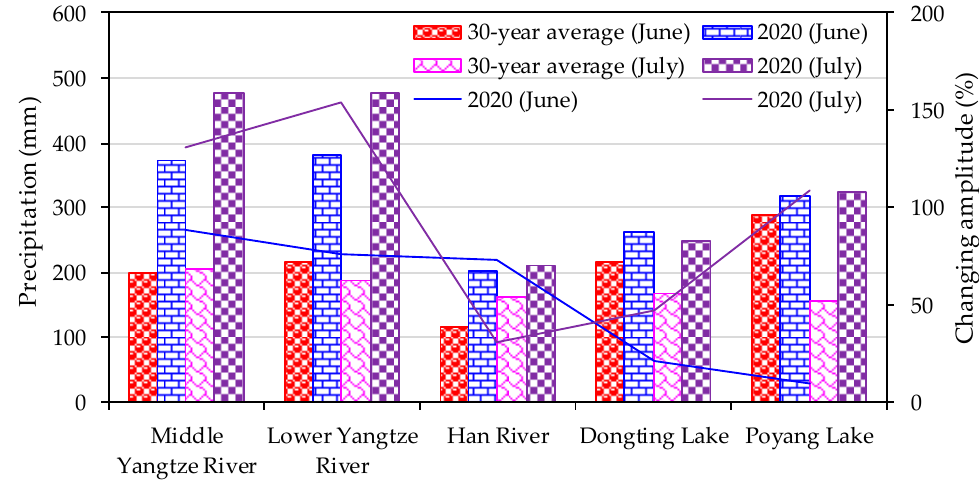
Figure 3. Precipitation in typical areas of the Yangtze River Basin during the plum rain season of 2020.